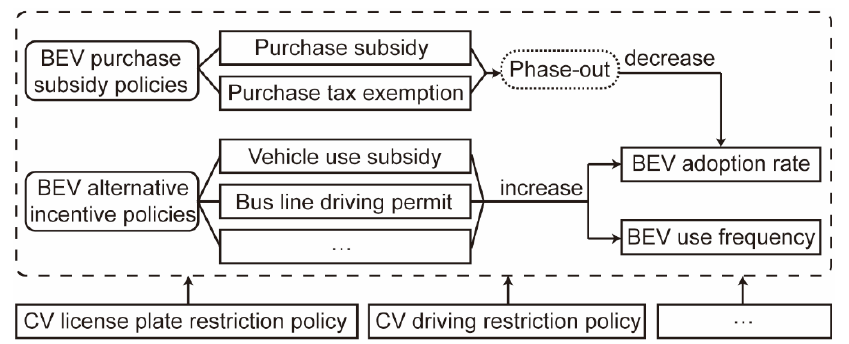
Figure 1. The relationship between purchase subsidy policies and alternative incentive policies. BEV = battery electric vehicle and CV = conventional vehicle.